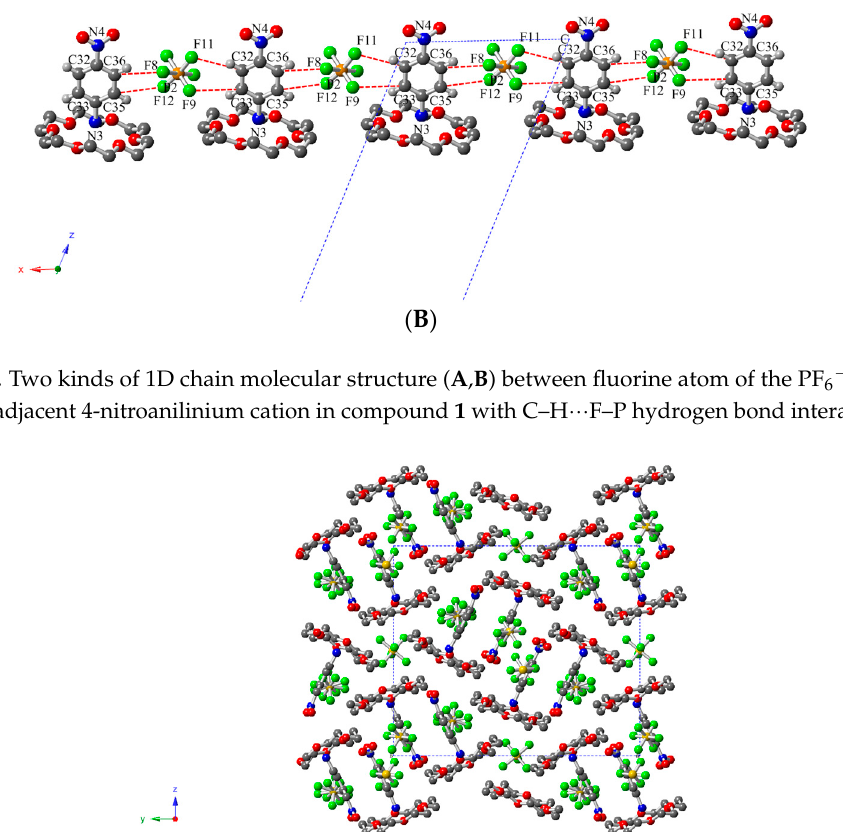
Figure 5. Self-assembly packing of the supramolecular cation and anion along the a -axis in compound 1 .